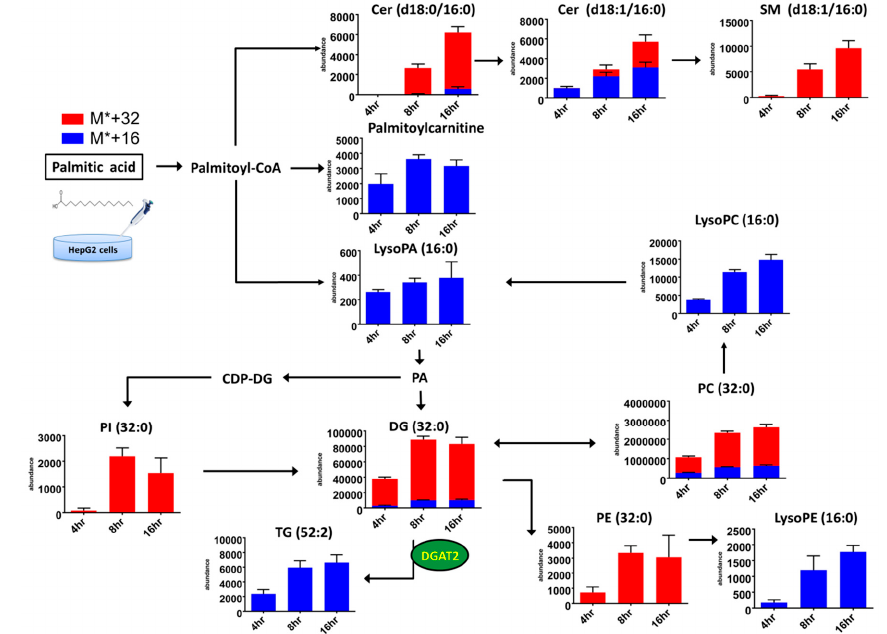
Figure 5. Metabolic pathways of and dynamic changes in lipid classes in HepG2 cells incubated for 4, 8, and 16 h with 0.3 mM 13 C16-palmitic acid. The cellular abundances of metabolites labeled with the stable isotope were marked as blue (M* + 16), and red (M* + 32) bar charts. (mean ± SD, n = 18, triplicates).